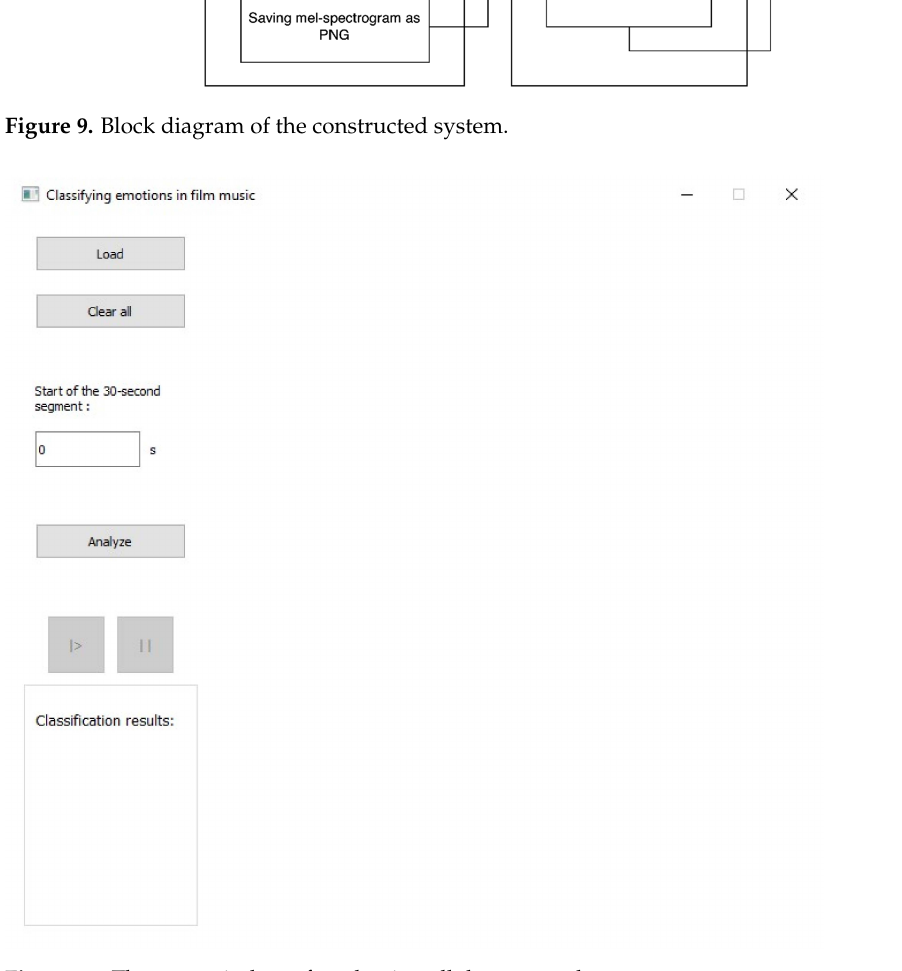
Figure 10. The start window after clearing all data